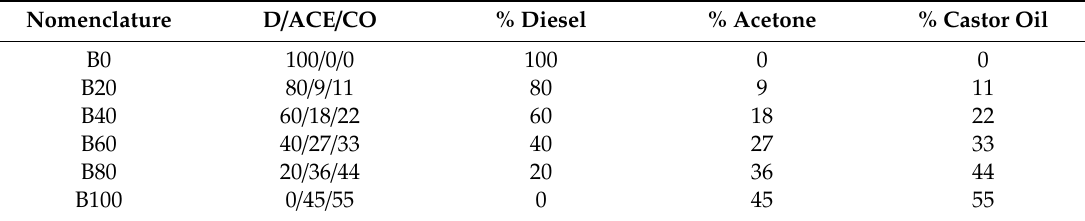
Table 6. Diesel / acetone / castor oil blends containing 45%